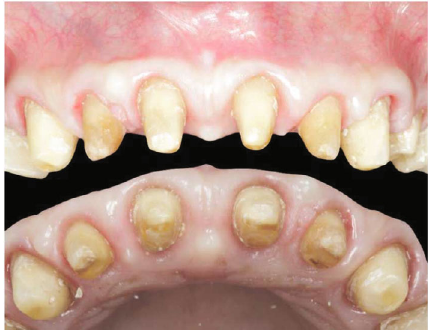
Figure 18: Abutment teeth 8 weeks after soft tissue maturation.